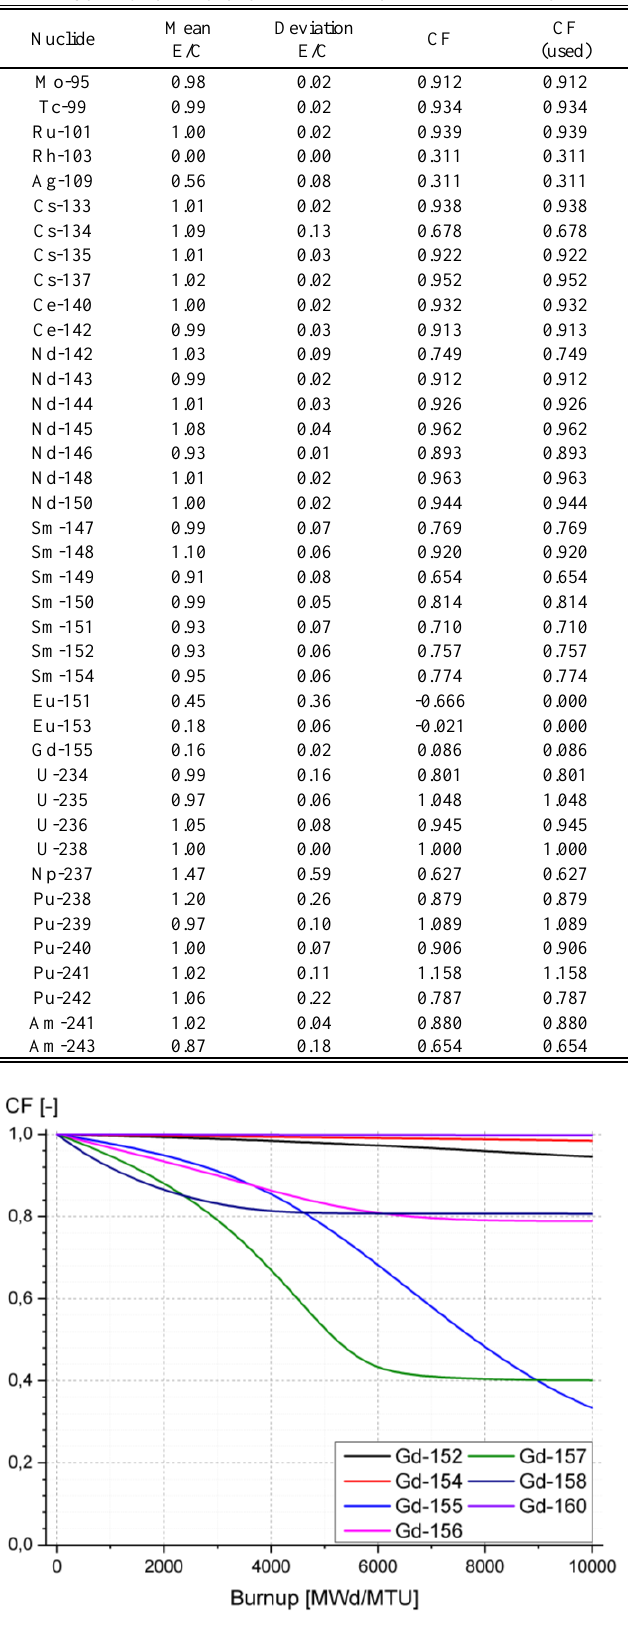
Fig. 2. Correction factors for isotopes of gadolinium in pins with Gd 2 O 3 burnable absorber as a function of